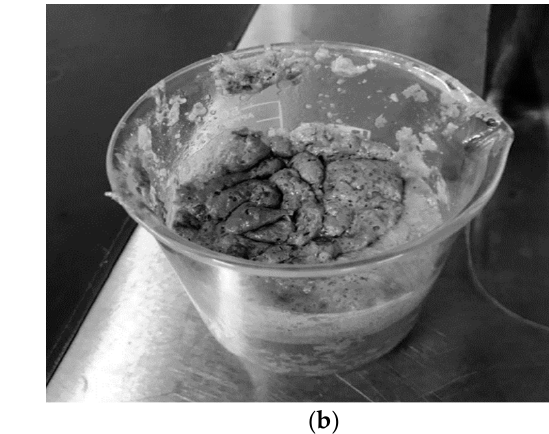
Figure 6. ( a ) During pre-treatment; ( b ) Collected coagulated FOG after pre-treatment. ( a ) Eco-flush TM dosed pre-treatment during and after 24 h aeration when the enzymatic pre-treatment is employed, ( b ) The coagulated FOG collected from the top of the pre-treatment unit.